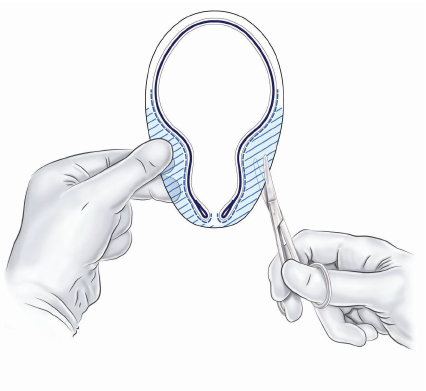
Figure 9: The lateral parts of the Onflex mesh are removed.